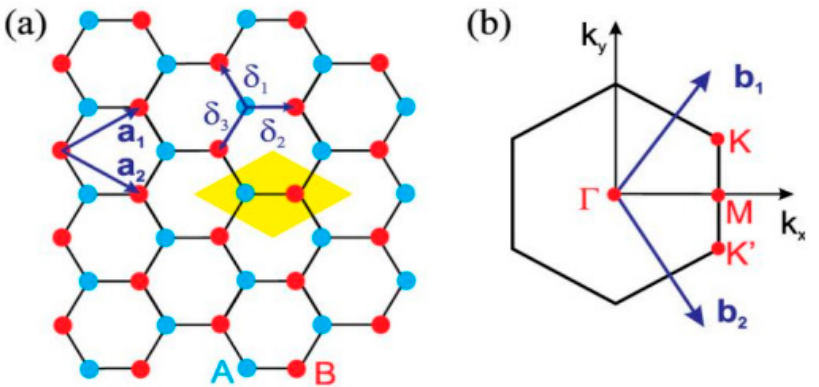
Figure 1. ( a ) Graphene hexagonal lattice, where unit vectors a 1 and a 2 represent sublattice and two atoms per unit cell, correspondingly. The bond length between the two nearest neighbor atoms is δ . Blue arrows represent lattice vectors. ( b ) b 1 and b 2 represent reciprocal lattice vectors at the Brillouin zone. © 2018 Springer Nature. Reprinted with Permission From [57].